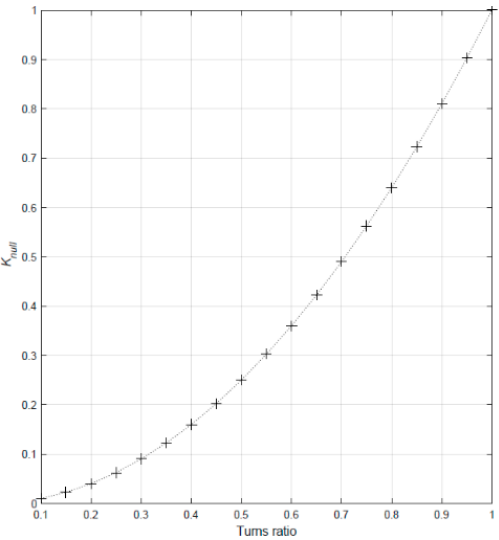
Figure 5. k null with different values of the turns-ratio.